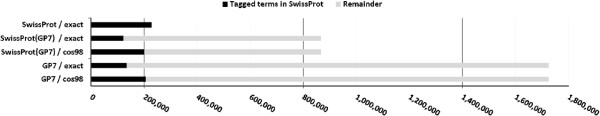
The tagging solutions have been used to annotated the lexical resource to determine how they comply with naming standards. The figure shows the tagging of entries from larger dictionary resources (SwissProt (GP7), GP7) against the smaller lexical resource (SwissProt). When using exact matching, only about 53% and 60% of the terms in the smaller resource can be identified by SwissProt (GP7) and GP7, respectively; whereas 88% and 90%, respectively, have been tagged when using alias matching. The same results are produced when using the small lexical resource as tagger against the larger lexical resources. The first experiment using exact matching demonstrates that the larger lexical resource uses slightly different notation standards which can be ignored when using alias matching. It is also remarkable that the smaller lexical resource seems to be already very effective in the tagging of the genes in the corpora indicating that the core terminology for gene mentions is already included in a comprehensive way.